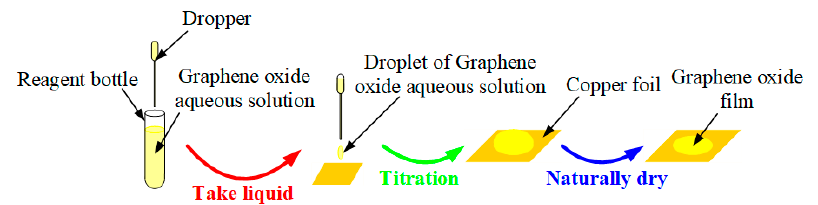
Figure 2. Production of graphene oxide (GO) films with copper substrates.